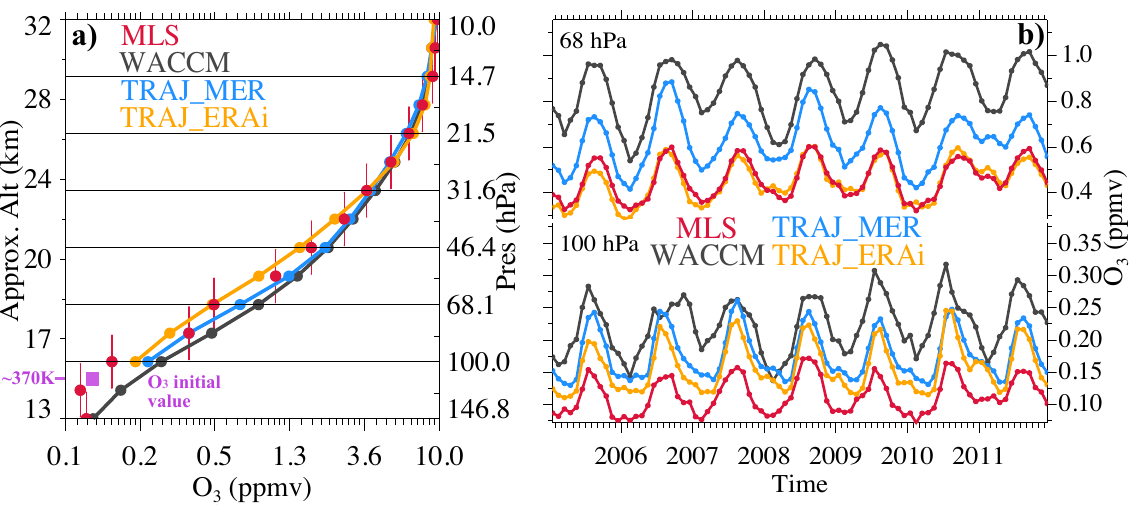
Figure 4. Tropical (a) vertical profile and (b) time series (100hPa, bottom panel; 68hPa, upper panel) of MLS, WACCM, and trajectory modeled O 3 driven by MERRA wind and ERAi wind, averaged over the deep tropics (18 ◦ N–18 ◦ S) from 2005 to 2011. Both WACCM and trajectory model results are weighted by the MLS averaging kernels. In (a) the x axis is in log scale to highlight the differences: the purple square indicates the initial O 3 values carried by parcels when they were first injected into the domain at 370K; the vertical bars in red indicate the MLS vertical resolutions at each of the MLS retrieval pressure levels.